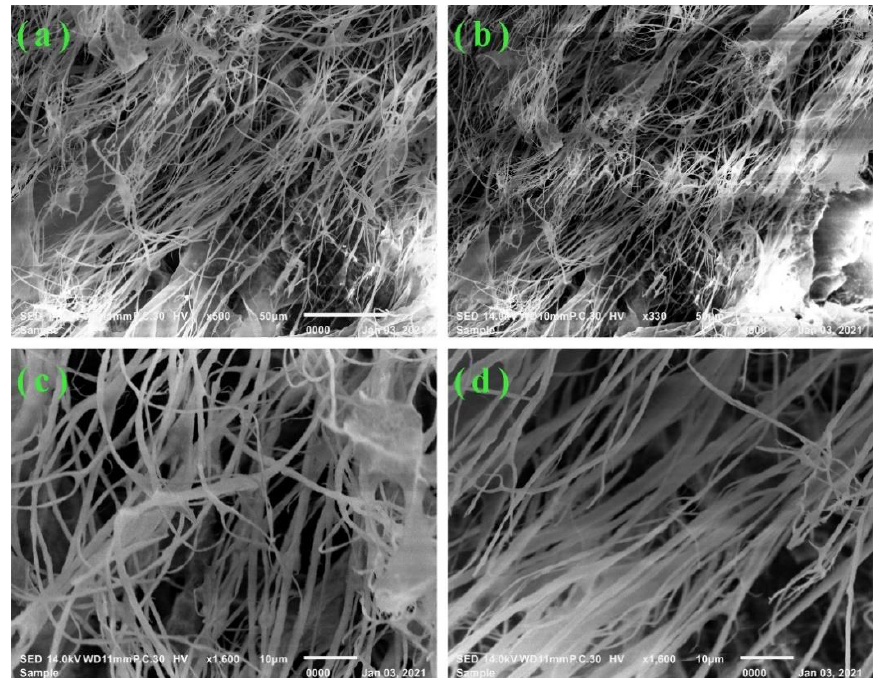
Figure 2. SEM images of polymer composite films at different magnification. ( a – d ) is the morphology observed at different magnification.